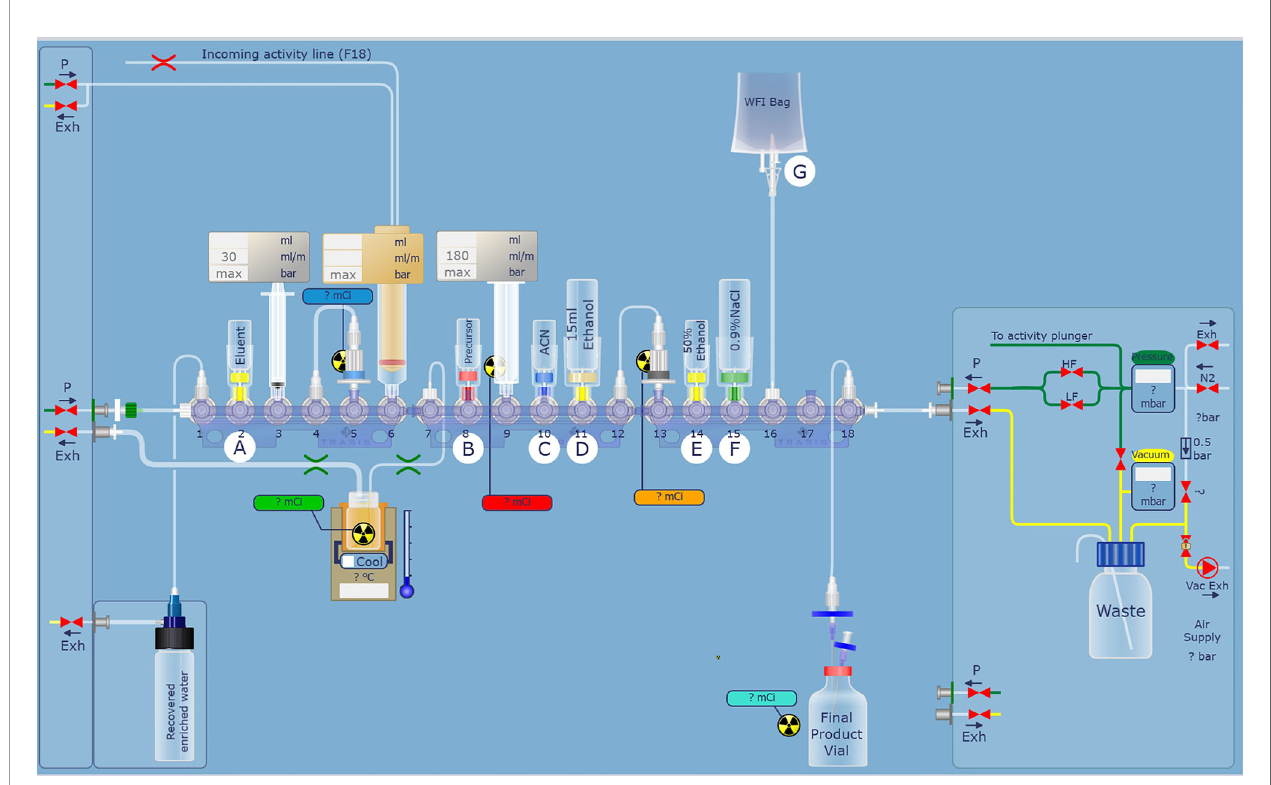
FIGURE 1 | Modi fi ed hardware and reagent kits for [ 18 F]AlF-NOTA-FAPI-04 based on AllinOne synthesis